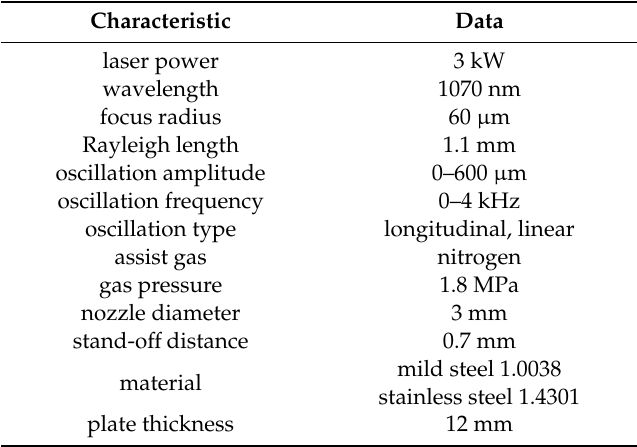
Table 1. Overview of the most relevant process conditions.